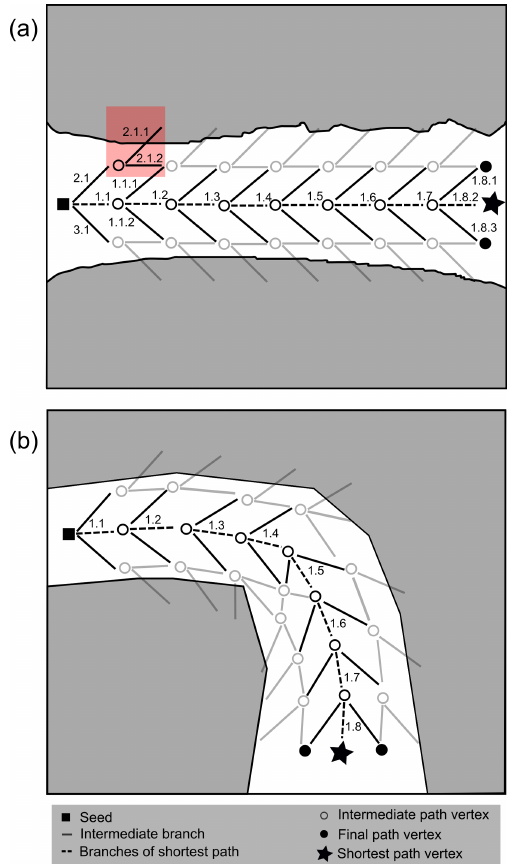
Figure 5. Generalisation of the fjord centreline approach where the centreline pathfinder algorithm is applied to a (a) straight ford and (b) a curved fjord. Grey regions represent land and ice, with white regions representing the fjord. From a seed point, new points are spawned, each time resulting in the creation of new branches. Where points intersect the land–ice boundary, branches are culled. The culling of branches 2.1.1 and 2.1.2 within the pink box in (a) and the selection of the shortest path are discussed in the